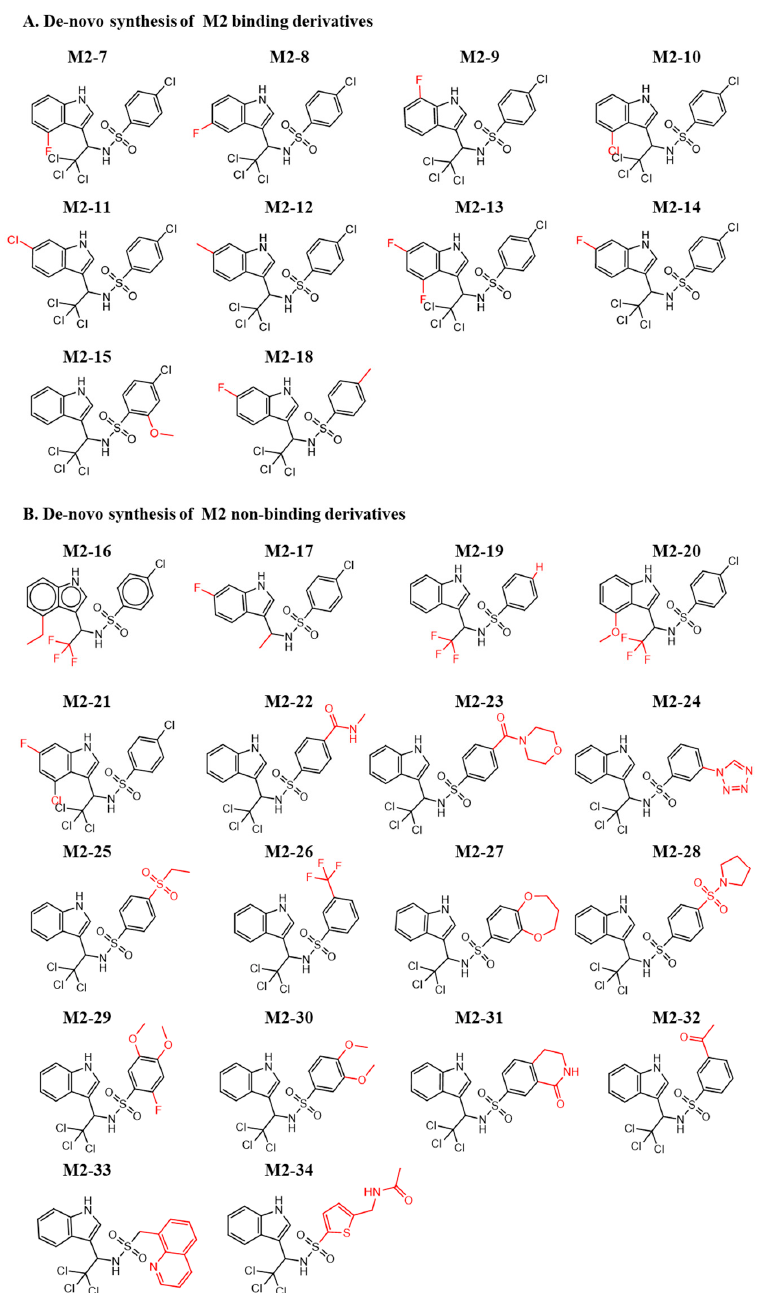
Figure 5. Chemical structures of de novo-synthesized M2-derived compounds. Derivatives of M2 that were synthesized and evaluated for their binding to MDM2. ( A ) Binding and ( B ) Nonbinding molecules. The red color shows the substitutions that differ from the original